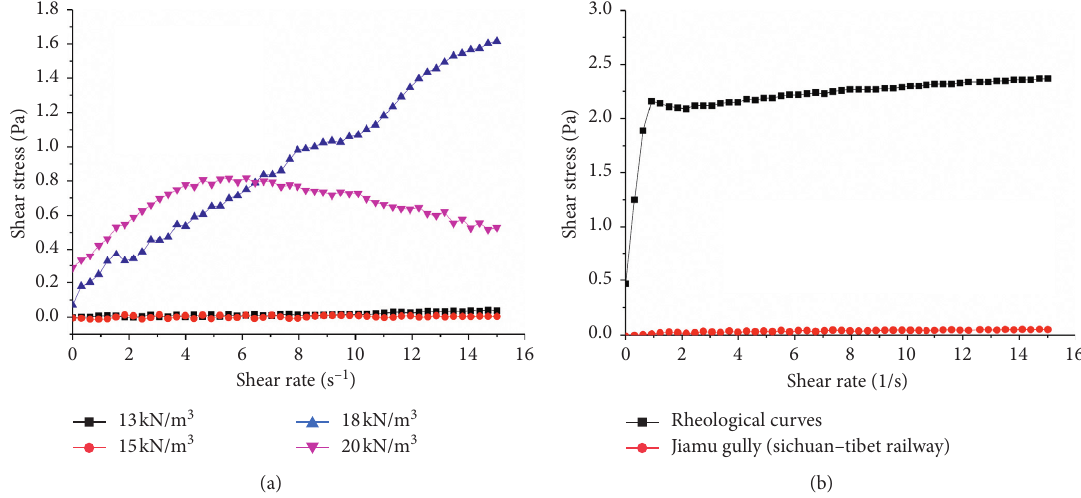
Figure 9: Comparison of different rheological models. (a) Rheological characteristics of debris flow with different bulk weights. (b) Comparison of the rheological curves of viscous debris flow with that of the Sichuan–Tibet